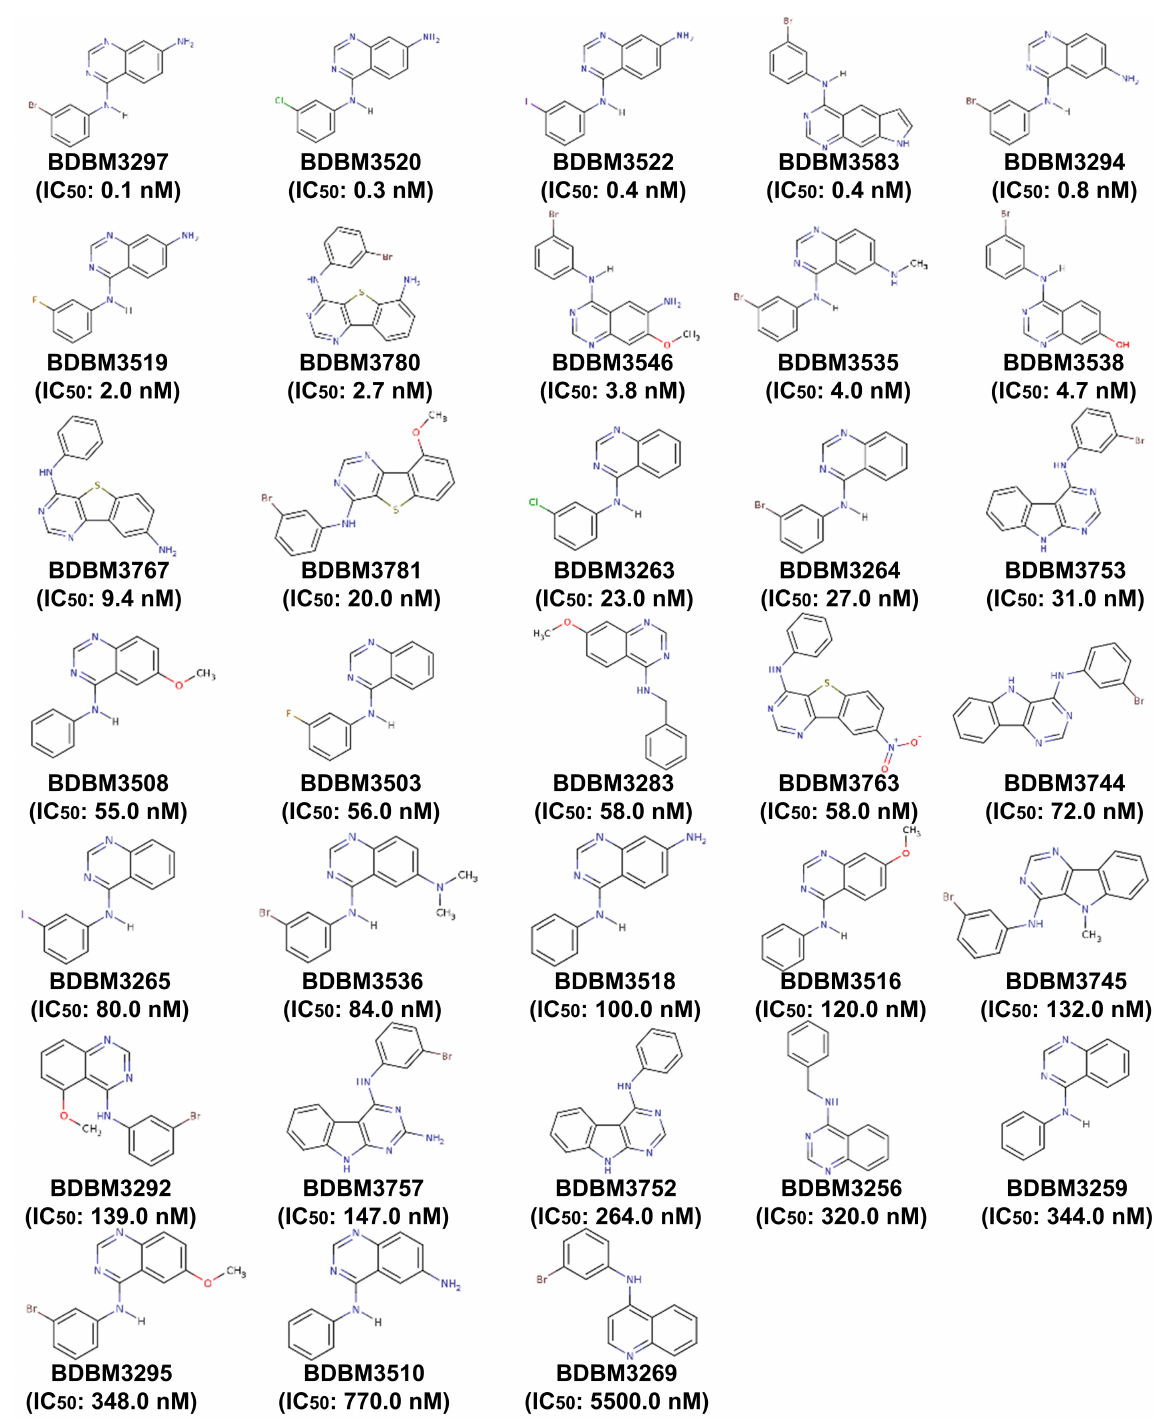
Figure A1. The chemical structures of 33 EGFR inhibitors comprising the training set for the construction of the 3D QSAR pharmacophore model.